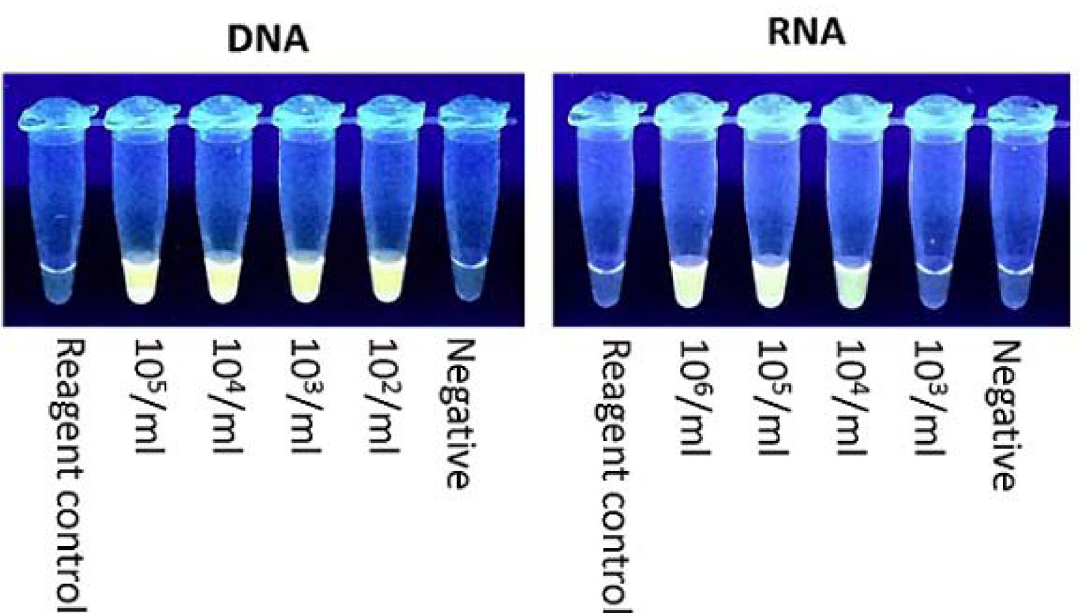
Fig 1. HIV-1 INT RT-LAMP Sensitivity. The RT-LAMP reaction tubes were observed under UV light. Representative tubes for amplification of DNA and RNA are